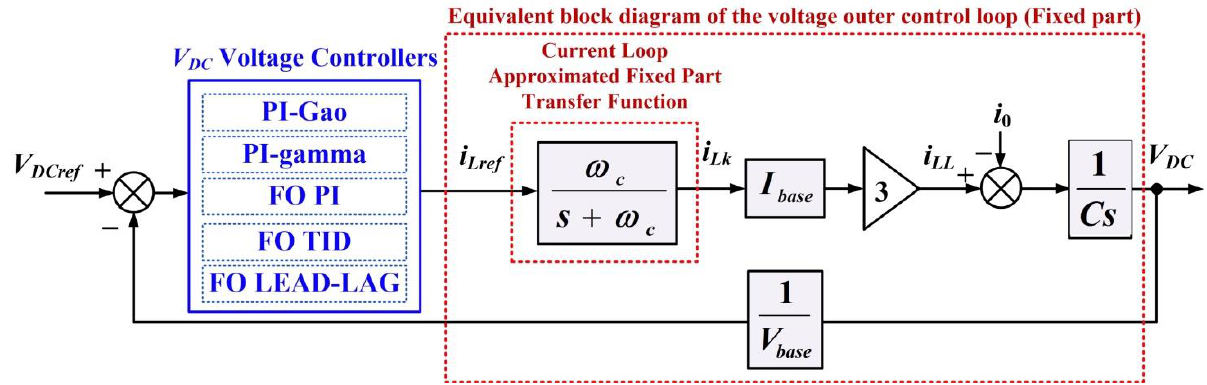
Figure 5. Block diagram modeled using the transfer function of the control system for the power electronic converter with PI-Gao, PI-gamma, FO PI, FO TID, and FO lead-lag voltage controllers.